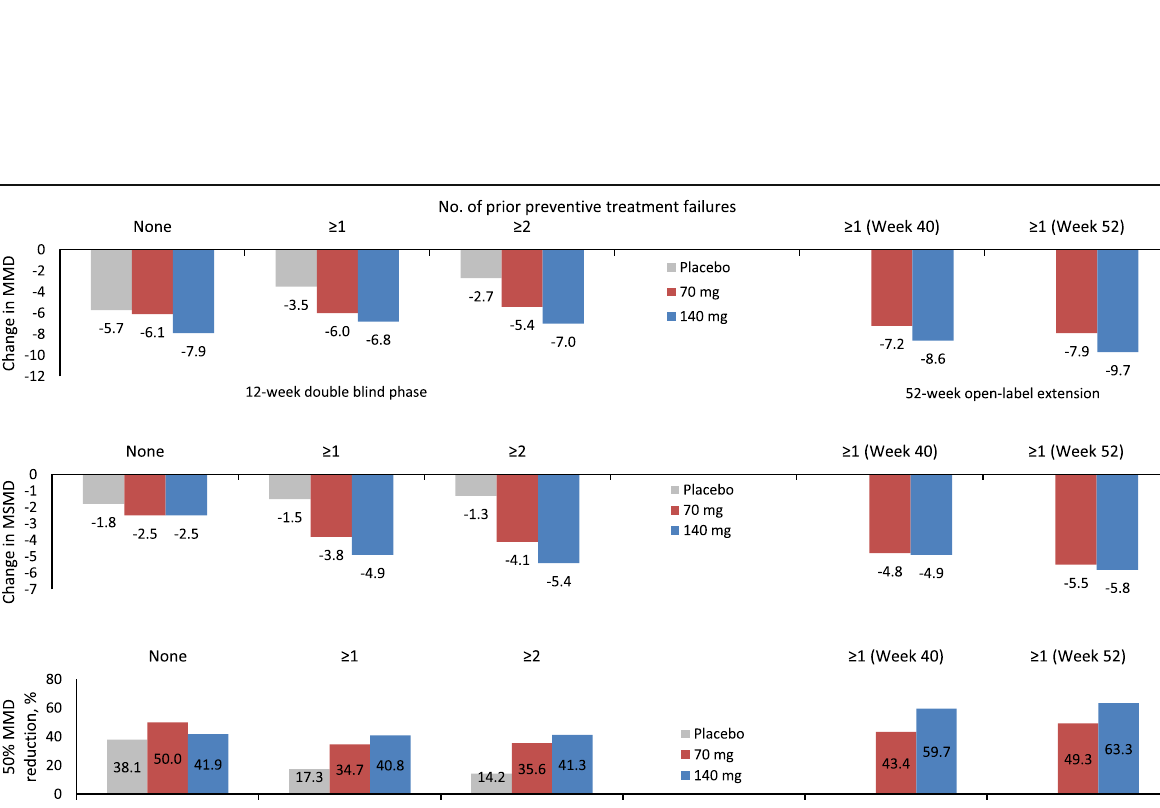
Fig. 2 Patients with chronic migraine: effect of erenumab on monthly migraine days, monthly migraine-specific medication days, and 50% reduction in monthly migraine days from baseline according to prior preventive treatment failures in the NCT02066415 trial [10] and its open-label extension